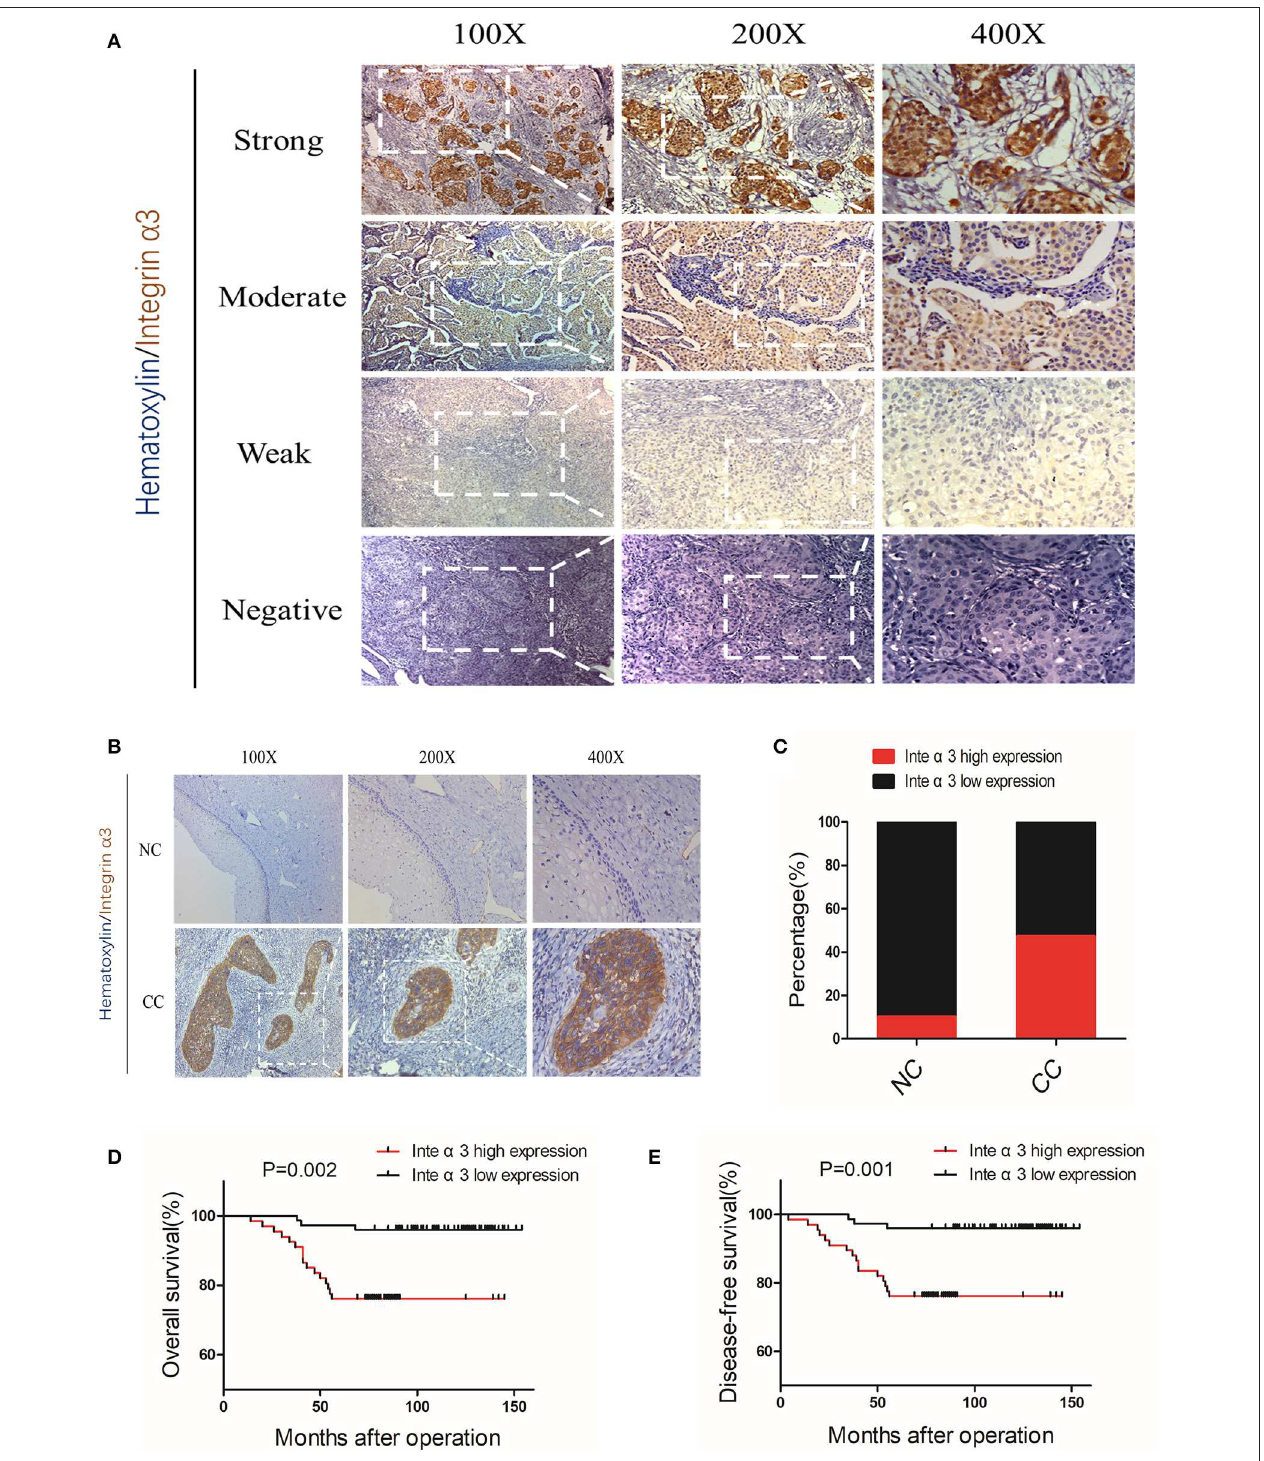
FIGURE 2 | Integrin α 3 is frequently upregulated in cervical cancer tissue and significantly associated with overall survival and disease-free survival. (A) Representative immunohistochemistry (IHC) image of cervical cancer (CC) tissue with different staining intensities of integrin α 3. (B) Representative IHC image of CC tissue of classic positive staining of integrin α 3 under different magnifications ( × 100, × 200, and × 400). (C) Bar graph presenting the statistical composition of high/low expression in normal cervix (NC) and CC tissues. (D,E) Overall survival and disease-free survival of patients with high or low integrin α 3 expression, respectively. The survival curve was constructed using the log-rank test. The P -value is shown in each panel.